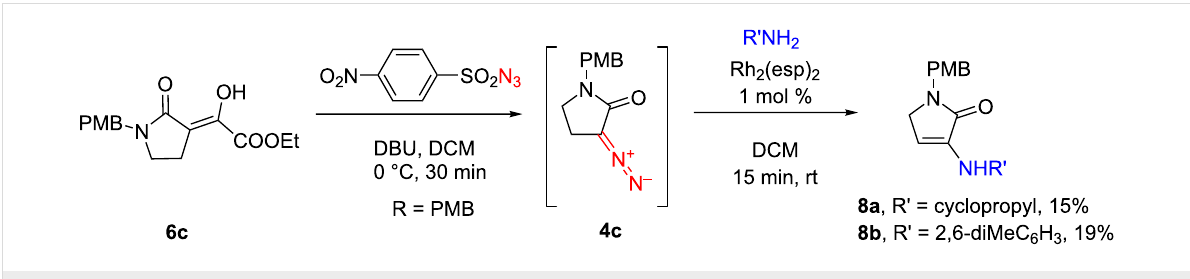
Scheme 2: Formation of the enamine coupling products 8a and b